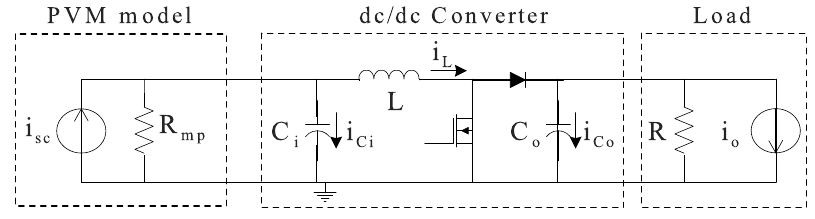
Figure 12. Loss-free PV system considering a bulk Norton